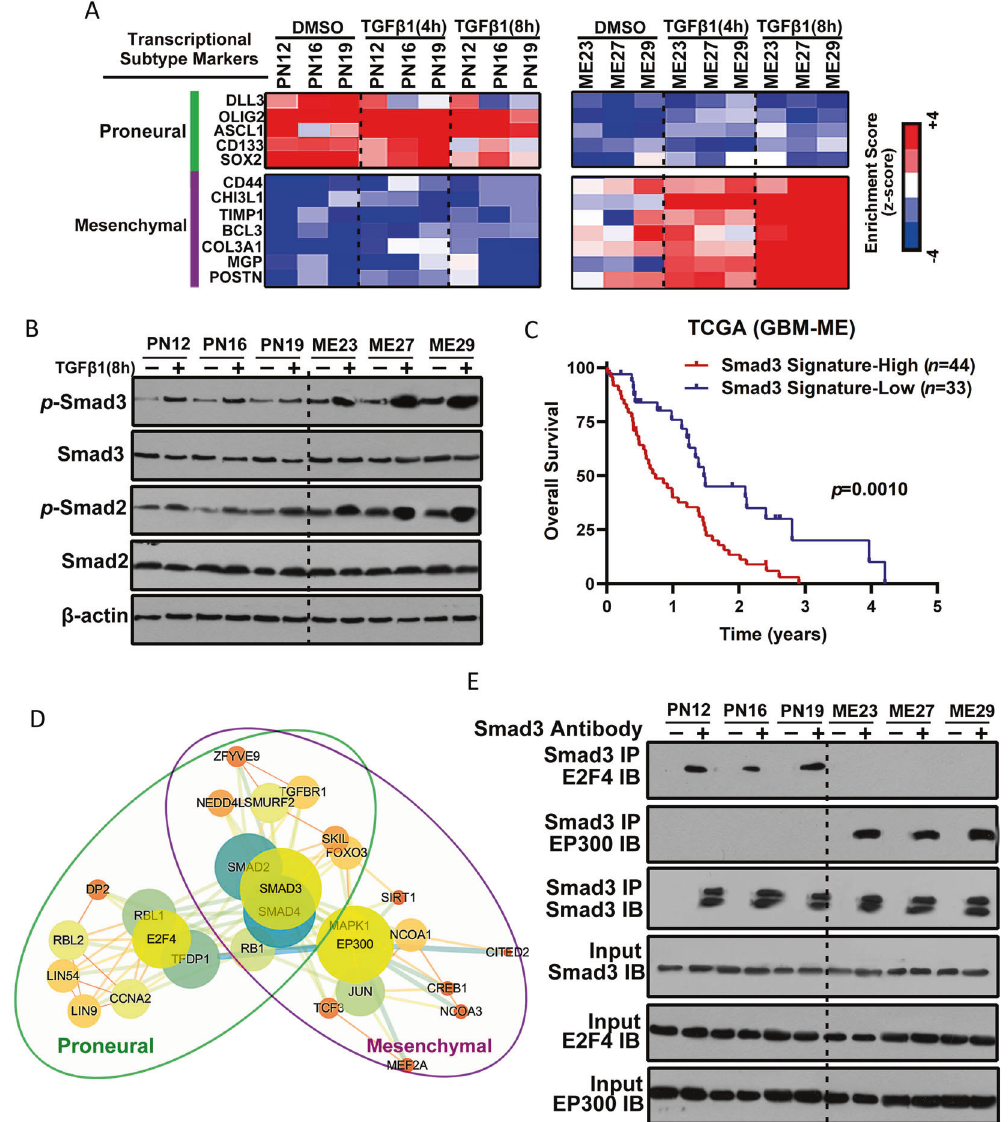
blotting analysis of SMAD2, p -SMAD2, SMAD3, and p -SMAD3 expression in proneural GSCs (PN12, PN16, and PN19) and mesenchymal GSCs (ME23, ME27, and ME29) with or without TGF- β 1 treatment for 8 h. C Kaplan – Meier survival curves for patients with mesenchymal GBM and a high Smad3 gene signature ( n = 44) and those with a low Smad3 gene signature ( n = 33). D Protein – protein interaction networks indicated by STRING and Cytoscape software show overlapping peaks in both proneural and mesenchymal GSCs and also identify those that are unique to a particular subtype of GSCs or shared between the proneural and mesenchymal GSCs. E Lysates from proneural GSCs and mesenchymal GSCs were subjected to immunoprecipitation using anti-Smad3 antibody and then immunoblotted with anti-E2F4 and anti-EP300 antibodies. GSCs glioblastoma stem